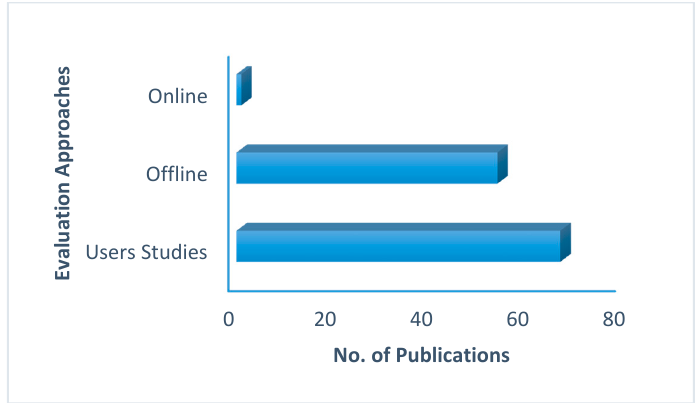
Figure 7. Classification by evaluation method. Table 5. Evaluation metrics.